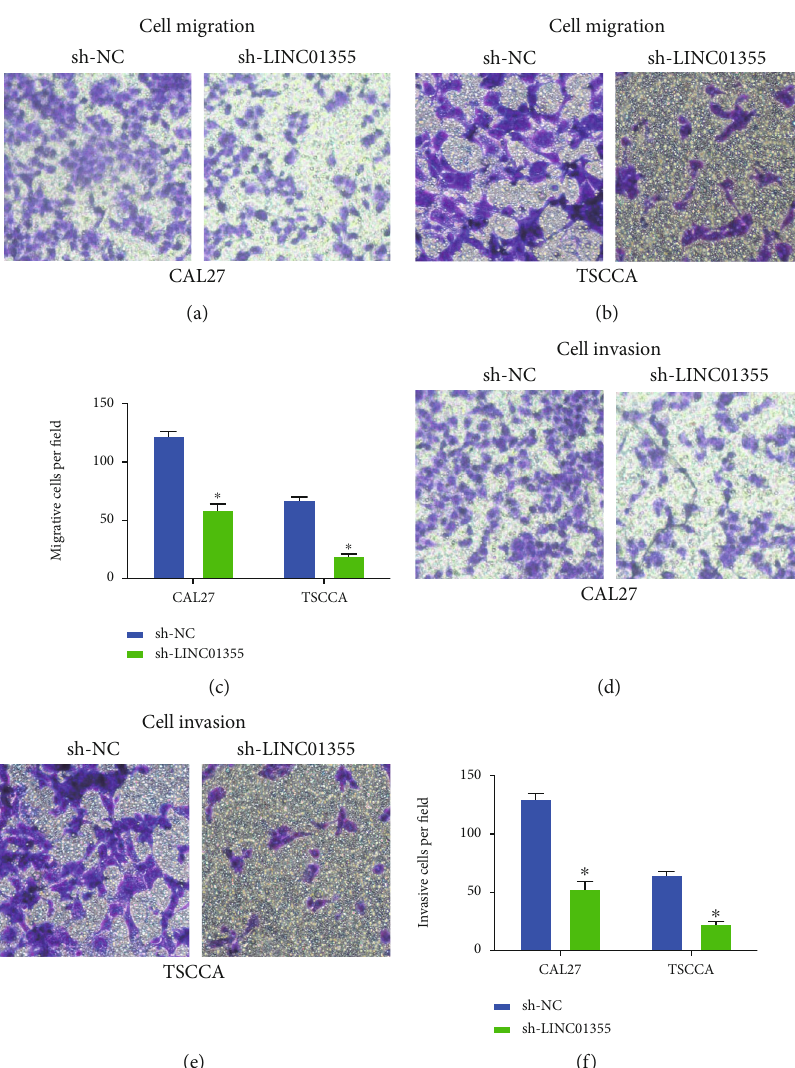
Figure 2: Loss of LINC01355 repressed OSCC cell migration and invasion. (a – c) Cell migration of CAL27 cells and TSCCA cells were analyzed after transfection with shRNA for LINC01355 using transwell migration assay. (d – f) Cell invasion of CAL27 cells and TSCCA cells were analyzed after transfection with the shRNA for LINC01355 using transwell invasion assay. ∗ p < 0 : 05